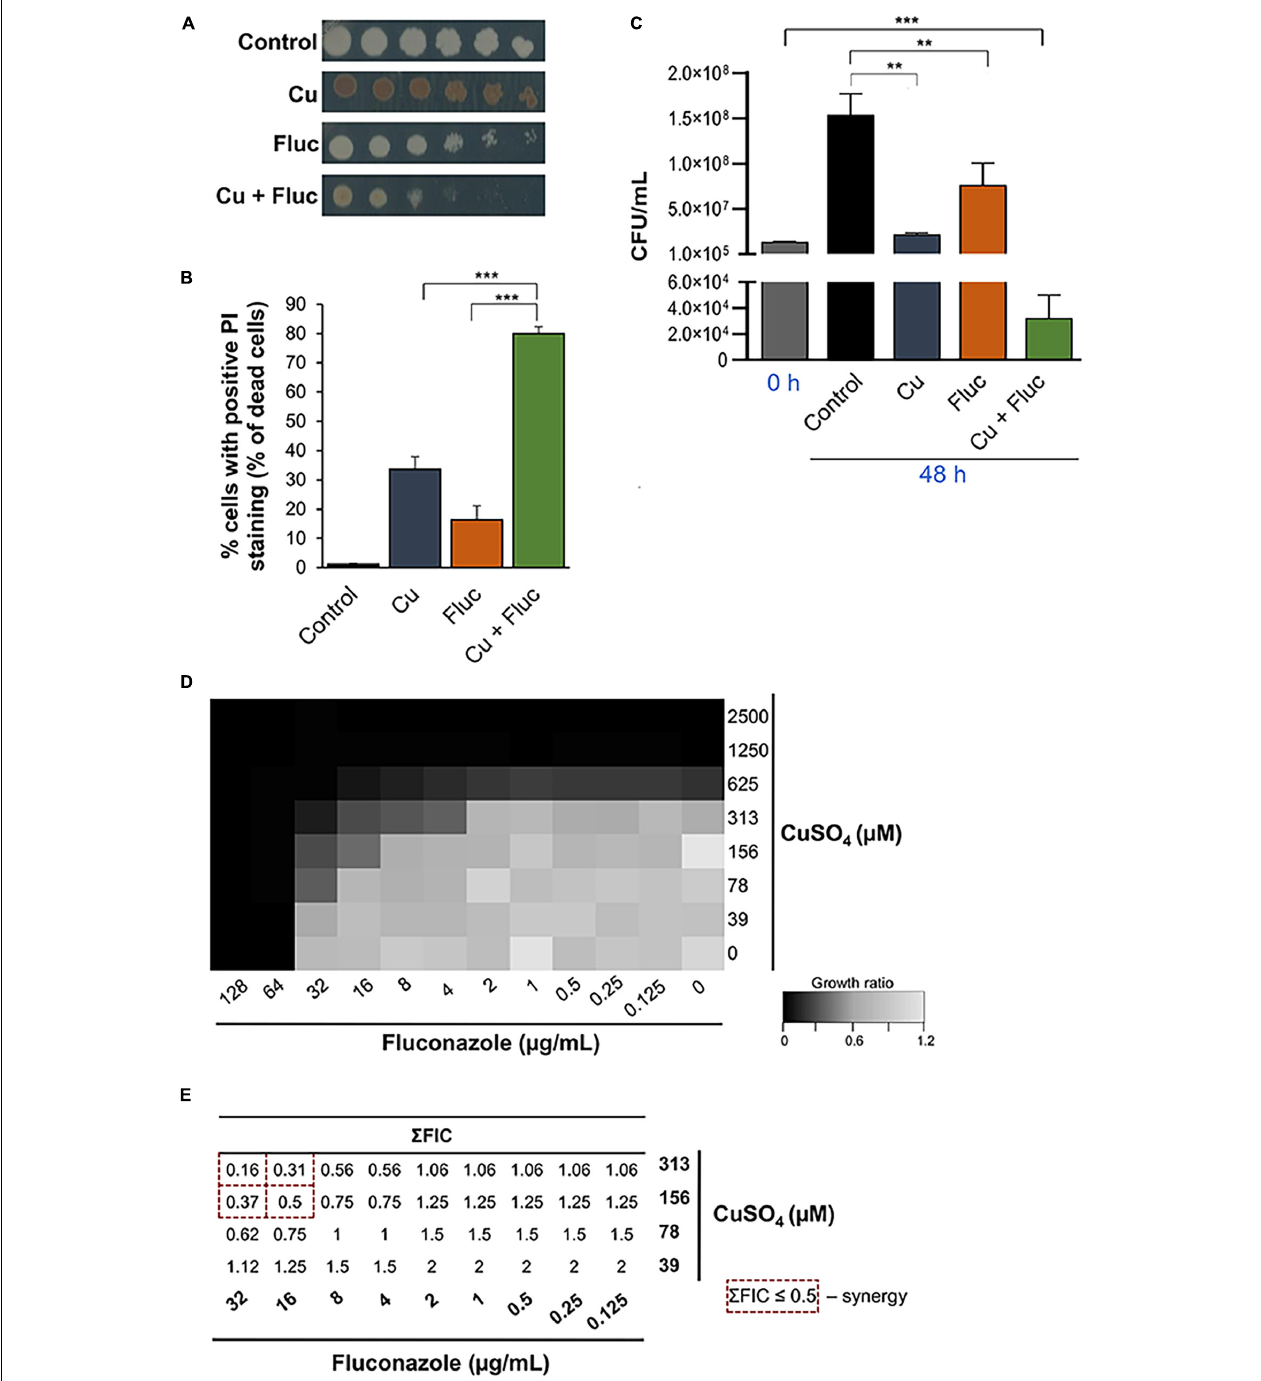
FIGURE 1 | Copper acts synergistically with fluconazole. (A) Growth sensitivity of Candida glabrata in SC agar plates (Control) containing 32 µ g/mL of fluconazole (Fluc), 625 µ M CuSO 4 (Cu), or a combination of both (Cu + Fluc). Growth was recorded after 48 h at 37 ◦ C. (B) Detection of dead cells by flow cytometry using propidium iodide staining (PI) under control conditions or after treatment with 625 µ M CuSO 4 (Cu), 32 µ g/mL fluconazole (Fluc), or both (Cu + Fluc) for 24 h. (C) Fungicidal effect of Cu + Fluc treatment. Cells treated as described in (B) were grown for 48 h and plated on YPD agar plates for CFU count. Significance of differences was calculated using Student’s T -test (** p -value < 0.05; *** p -value < 0.005). (D) Checkerboard assays. Cells were exposed to all the possible combinations of CuSO 4 and fluconazole (ranging between 2500 and 39 µ M for CuSO 4 and 128 and 0.125 µ g/mL for fluconazole). Growth ratios were evaluated after 24 h at 37 ◦ C by measuring OD 600 and normalizing it relative to untreated controls (see gradient bar). (E) Fractional inhibitory concentration (FIC) index ( P FIC) was calculated for the indicated combinations of fluconazole and CuSO 4 . The dashed red squares indicated the Cu + Fluc concentrations where synergy is observed.